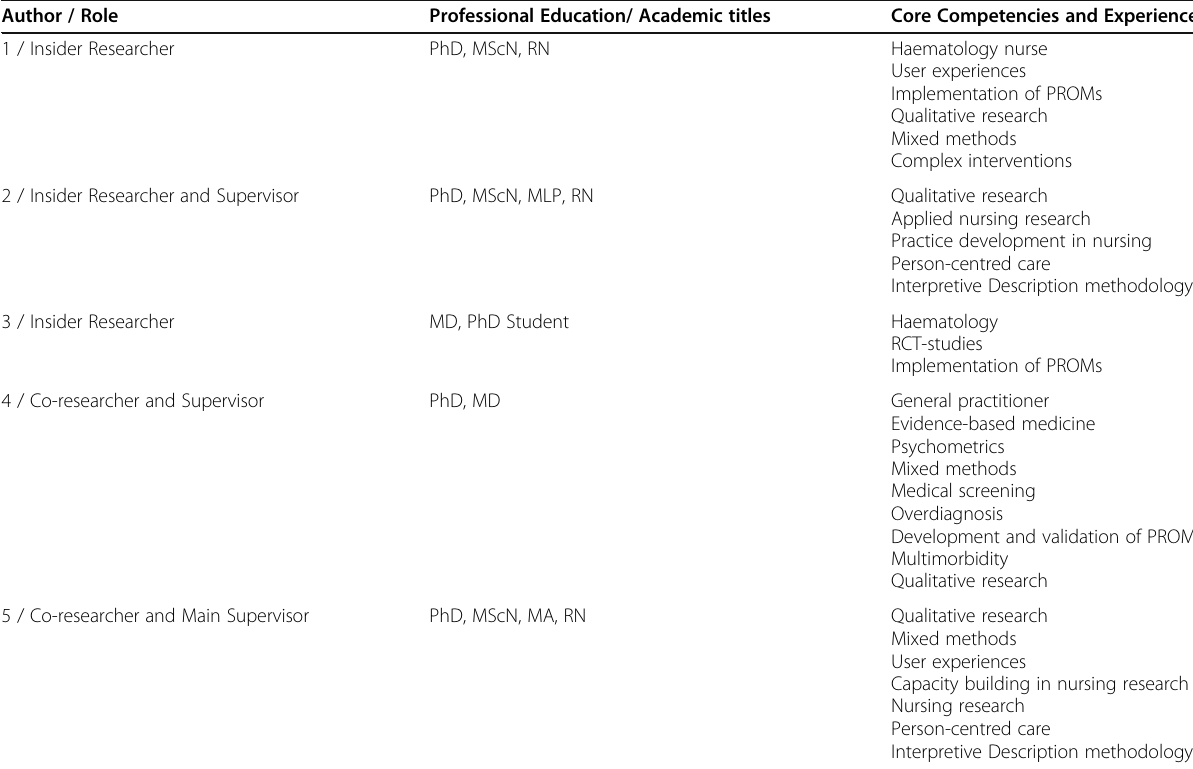
Table 2 Qualifications and experiences of the research